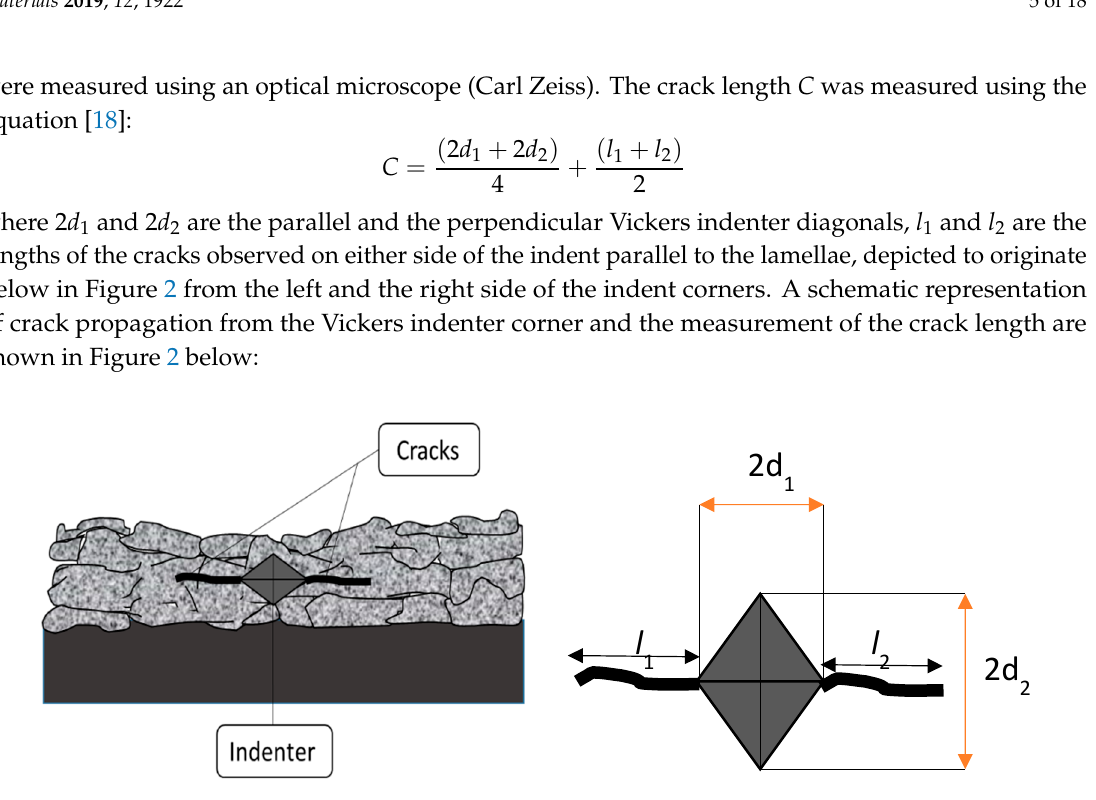
Figure 2. Schematic representation of crack propagation from Vickers indentation and the measurement of crack length.